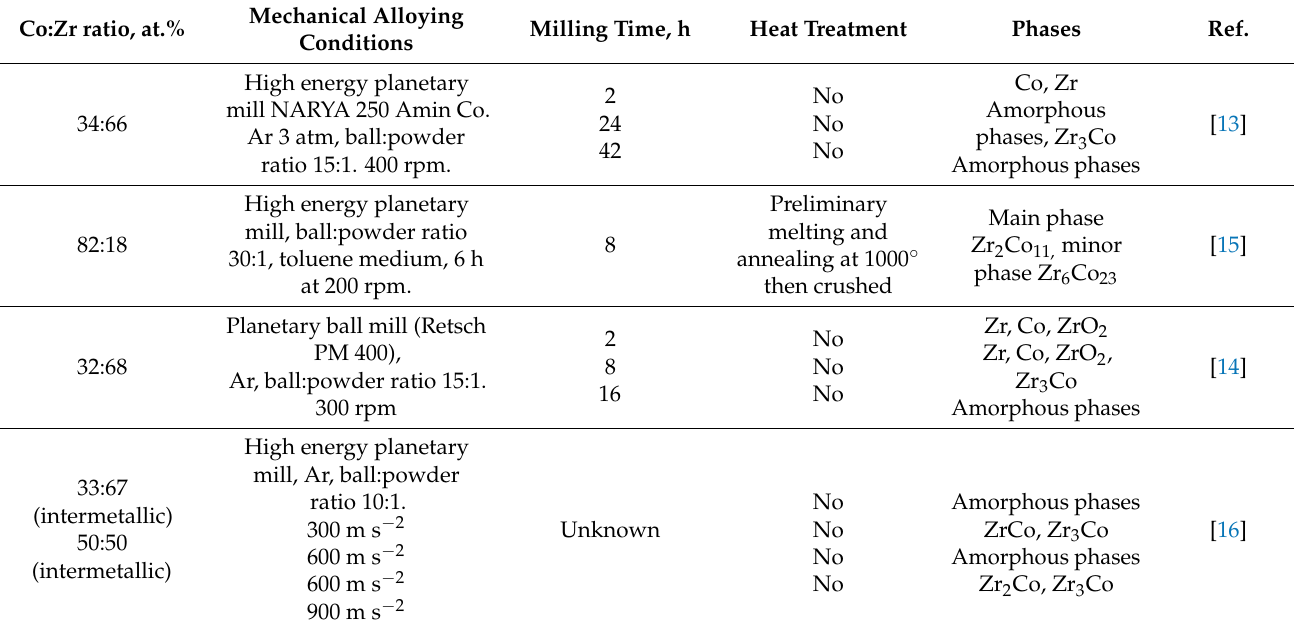
Table 1. Structural parameters of Co-Zr powders after mechanical